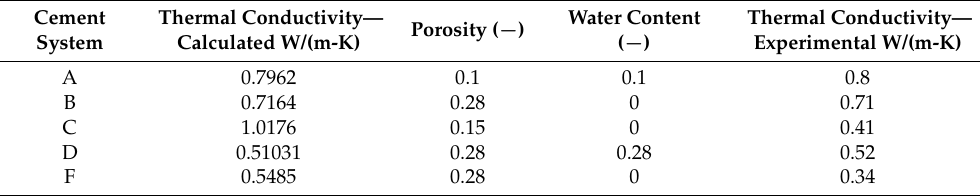
Table 17. Thermal conductivity values using porosity and water content as additional